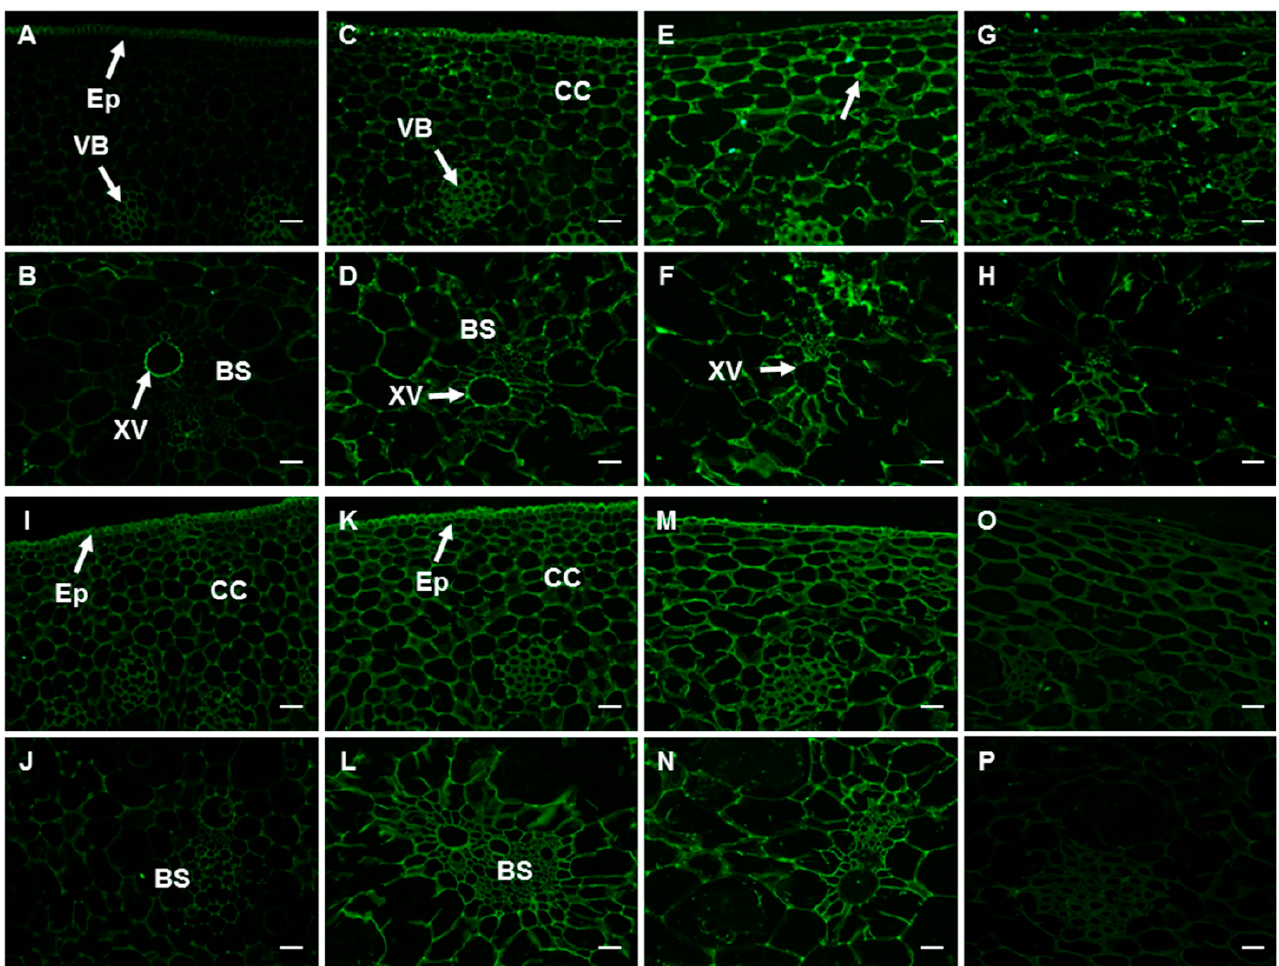
Figure 7. Spatio-temporal changes in the epitopes of LM18 ( A – H ) and CCRC-M38 antibodies ( I – P ) in banana ( Musa spp. AAA) peel during fruit development and ripening.( A , B , I , J ) Peel of fruits just emerging from the bunch; ( C , D , K , L ) Fruit peel at 35 d; ( E , F , M , N ) Fruit peel at harvest; ( G , H , O , P ) Fruit peel after ripening. CC: cortex cells; Ep: epidermis; LC: latex cells; XV: xylem vessel; BS: vascular bundle sheath; VB: vascular bundle. Bar = 50 µ